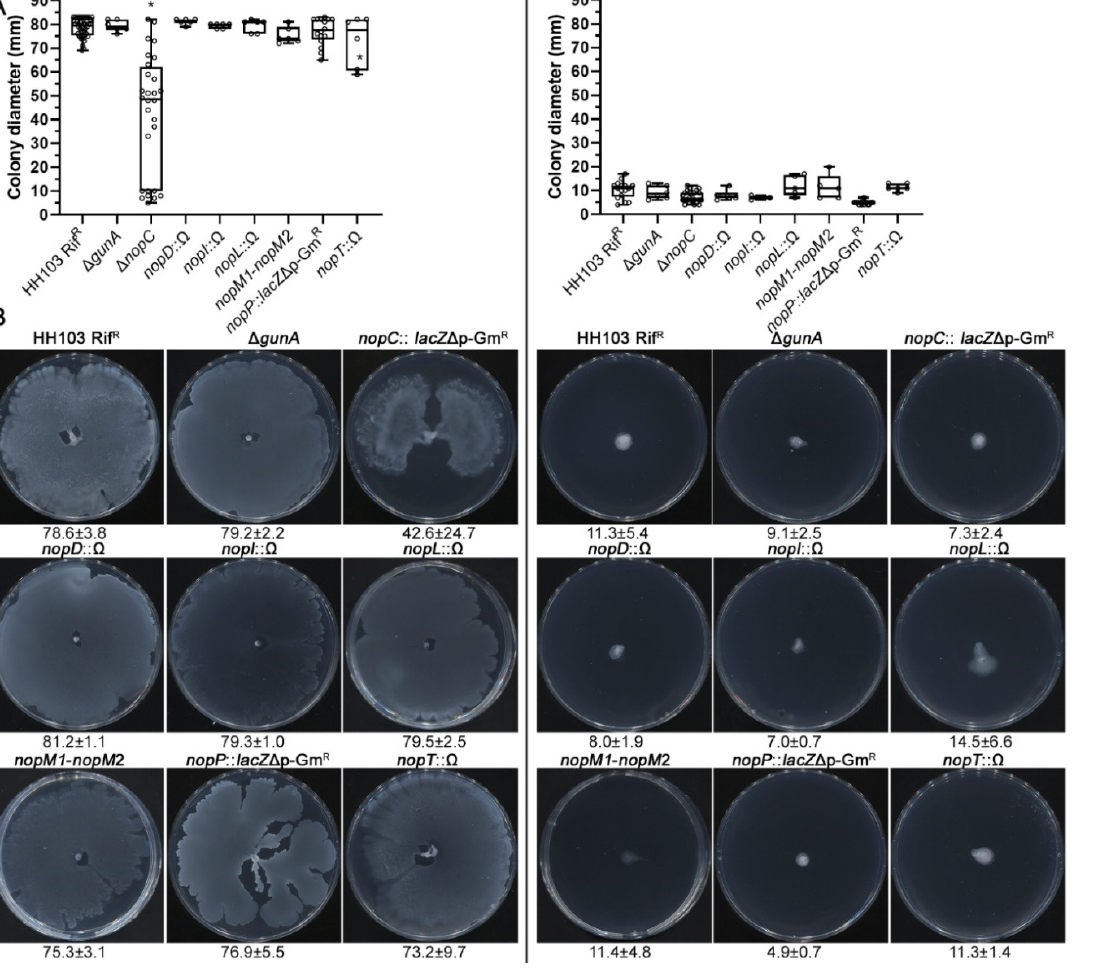
Figure 6. Role of the different T3SS effectors on the S. fredii HH103 surface translocation in the presence of genistein. Surface motility experiments were performed on minimal medium (MM) using 0.4% agarose as gelling agent and scored at 72 h. ( A ). Box and whisker plots from at least three biological replicates performed with three technical replicates. Asterisks (*) indicate significant differences with the corresponding control sample using the non-parametric test of Mann–Whitney, α = 1%. ( B ). Representative pictures of the motilities exhibited in the presence of genistein by the different S. fredii HH103 mutants analysed. Values under images represent the average and standard deviation of surface migration (given in millimetres and determined as described in the text).